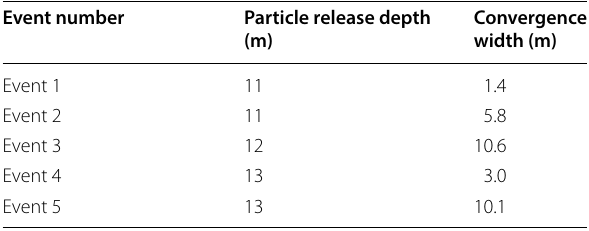
Table 6 Estimated particle release depth by linear